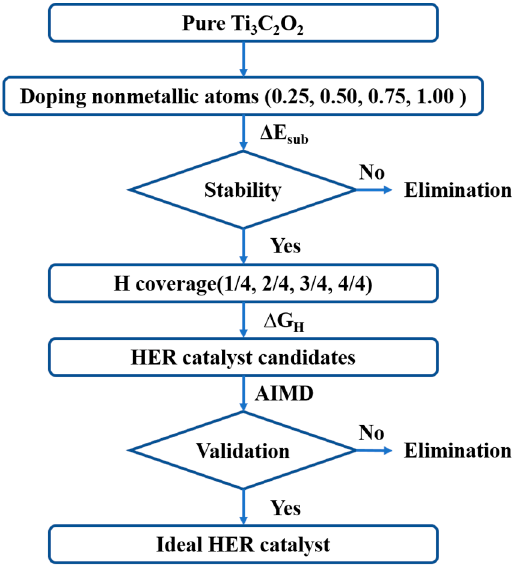
Figure 2. The workflow of calculating and screening nonmetallic element doped Ti 3 C 2 O 2 HER cata- lyst.